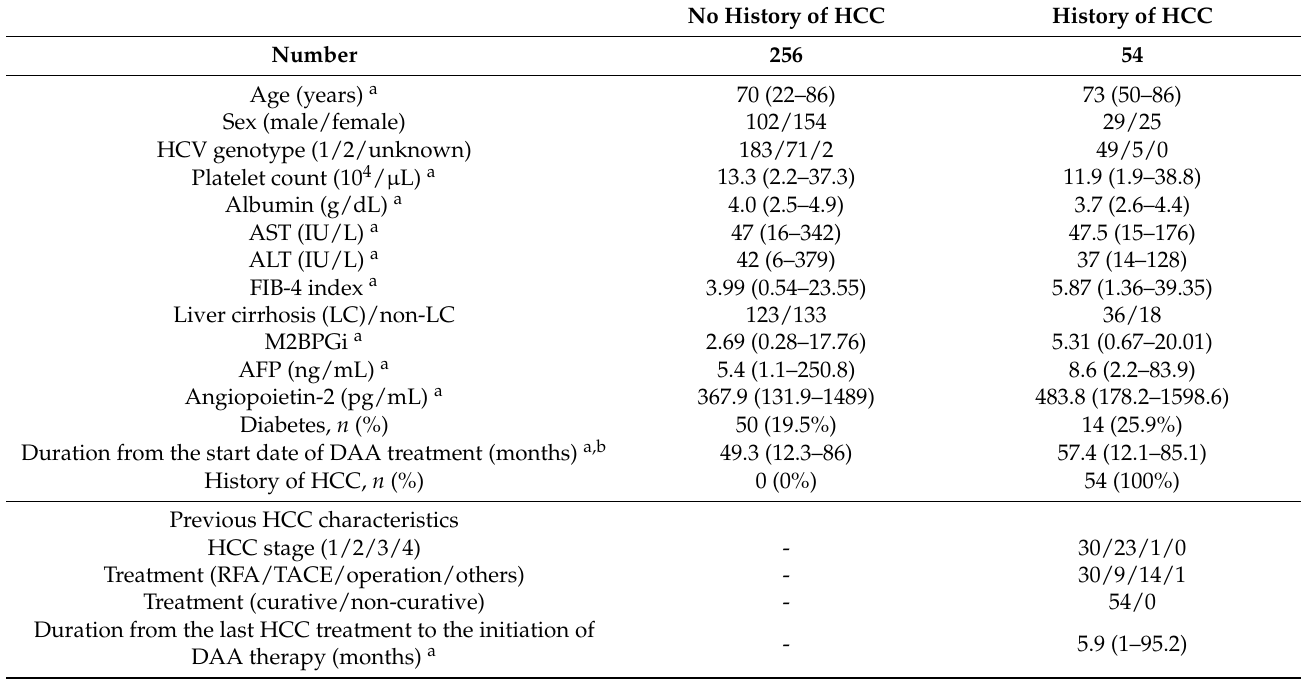
Table 1. Baseline characteristics of patients without or with a history of